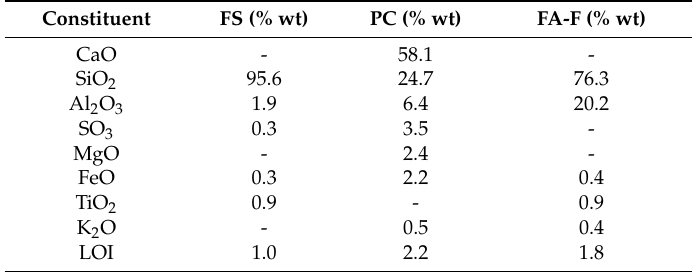
Table 2. Chemical composition of Portland cement (PC), Fine sand (FS) and Fly ash (FA-F).